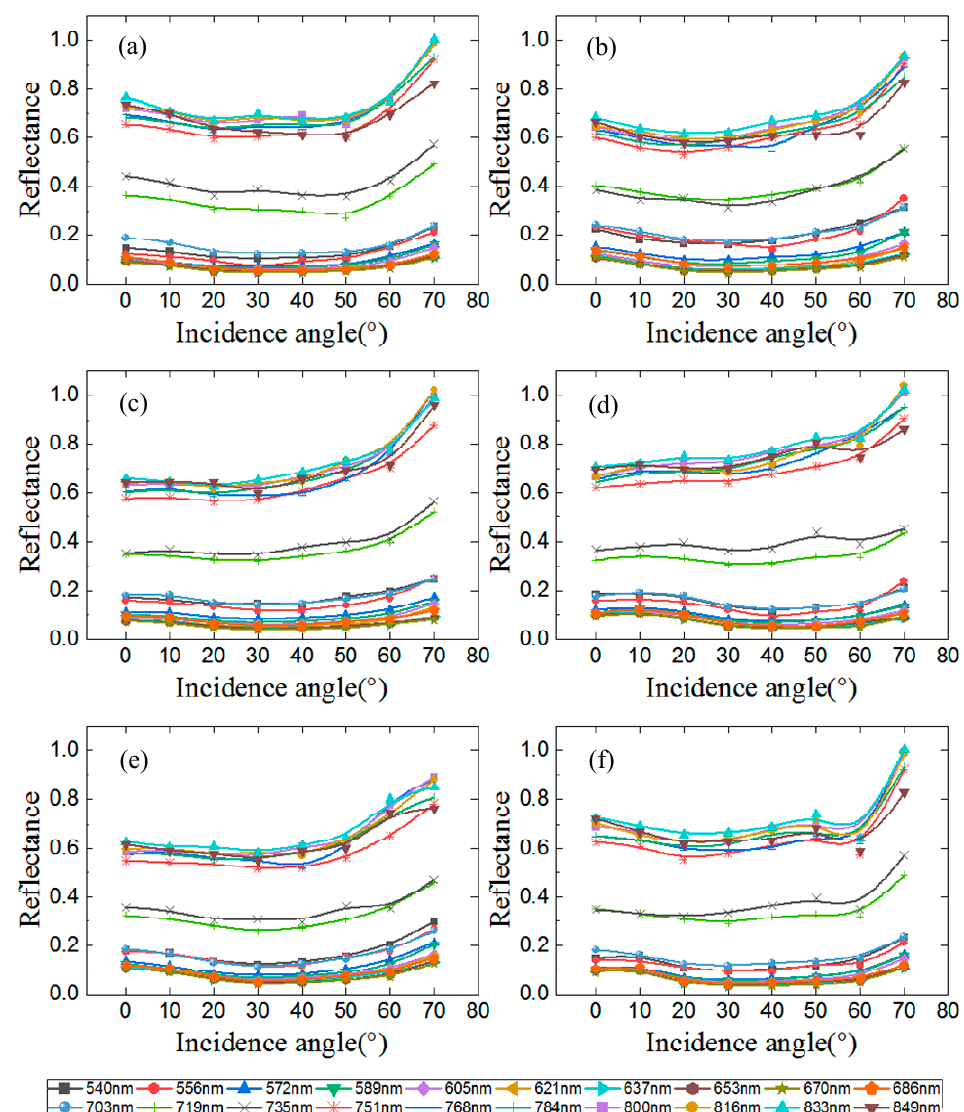
Figure 7. Relative correction results of all wavelengths for the six leaf targets versus incidence angle, the 99% standard reflectance panel is used as a reference. ( a ) Ficus elastica , ( b ) Epipremnum aureum , ( c ) Aglaonema modestum , ( d ) Hibiscus rosa-sinensis Linn , ( e ) Spathiphyllum kochii and ( f ) Kalanchoe blossfeldiana Poelln .